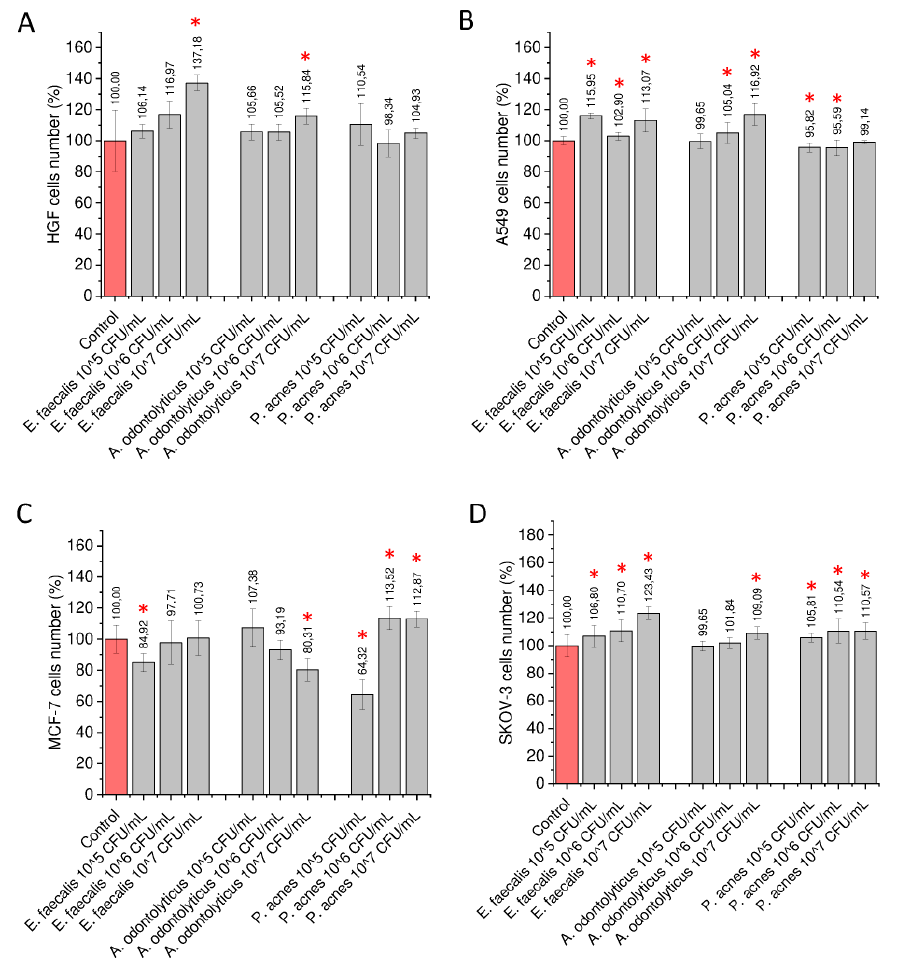
Figure 1. Impact of heat-inactivated bacteria on overall number of gingival and cancer cells. Increase of number of human primary gingival fibroblasts (HGF) (panel A ), lung carcinoma A549 (panel B ), breast cancer MCF-7 (panel C ), and ovarian carcinoma SKOV-3 (panel D ) cells upon stimulation with E. faecalis ATCC 29212, A. odontolyticus ATCC 17929, and P. acnes ATCC 11827 at concentrations of 10 5 , 10 6 , and 10 7 CFU / mL. Results are presented as mean ± SD from 6 to 12 individual measurements. * indicates statistical significance ( p < 0.05) compared to unstimulated control cells.